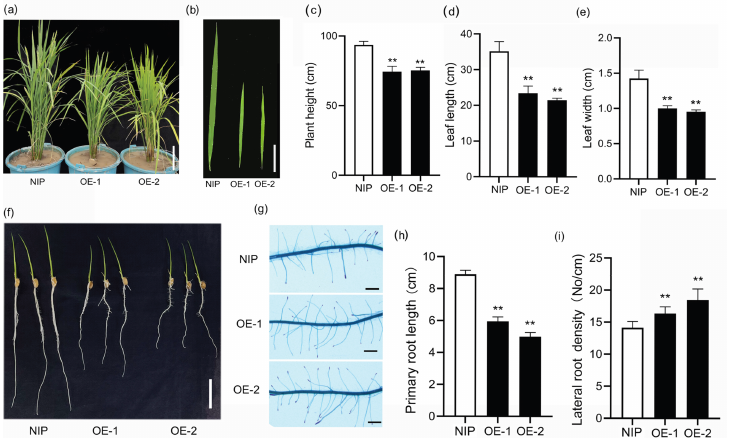
Figure 7. Phenotypes of transgenic rice over-expressing SiLBD21 . ( a , b ) The plant architecture and leaves at the grain-filling stage. ( c – e ) Plant height, leaf length and width at the grain-filling stage, n > 10. ( f ) Seven-day WT and transgenic plants’ root length. ( g ) Primary root zones in ( f ) stained with methylene. ( h , i ) Primary root length and lateral root density of 7-day WT and transgenic lines, n > 30. Error bars represent the standard deviations. Statistically significant differences are indicated: ‘**’, p ≤ 0.01 (Student’s t -test). Bars = 10 cm in ( a , b ), 2 cm in ( f , g